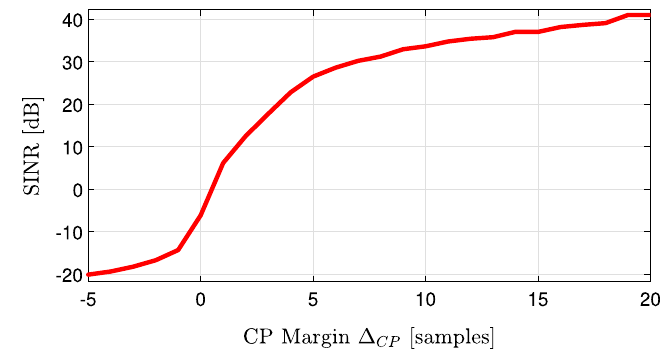
Fig. 11 SINR of the information signal for different values of (cid:31) cp